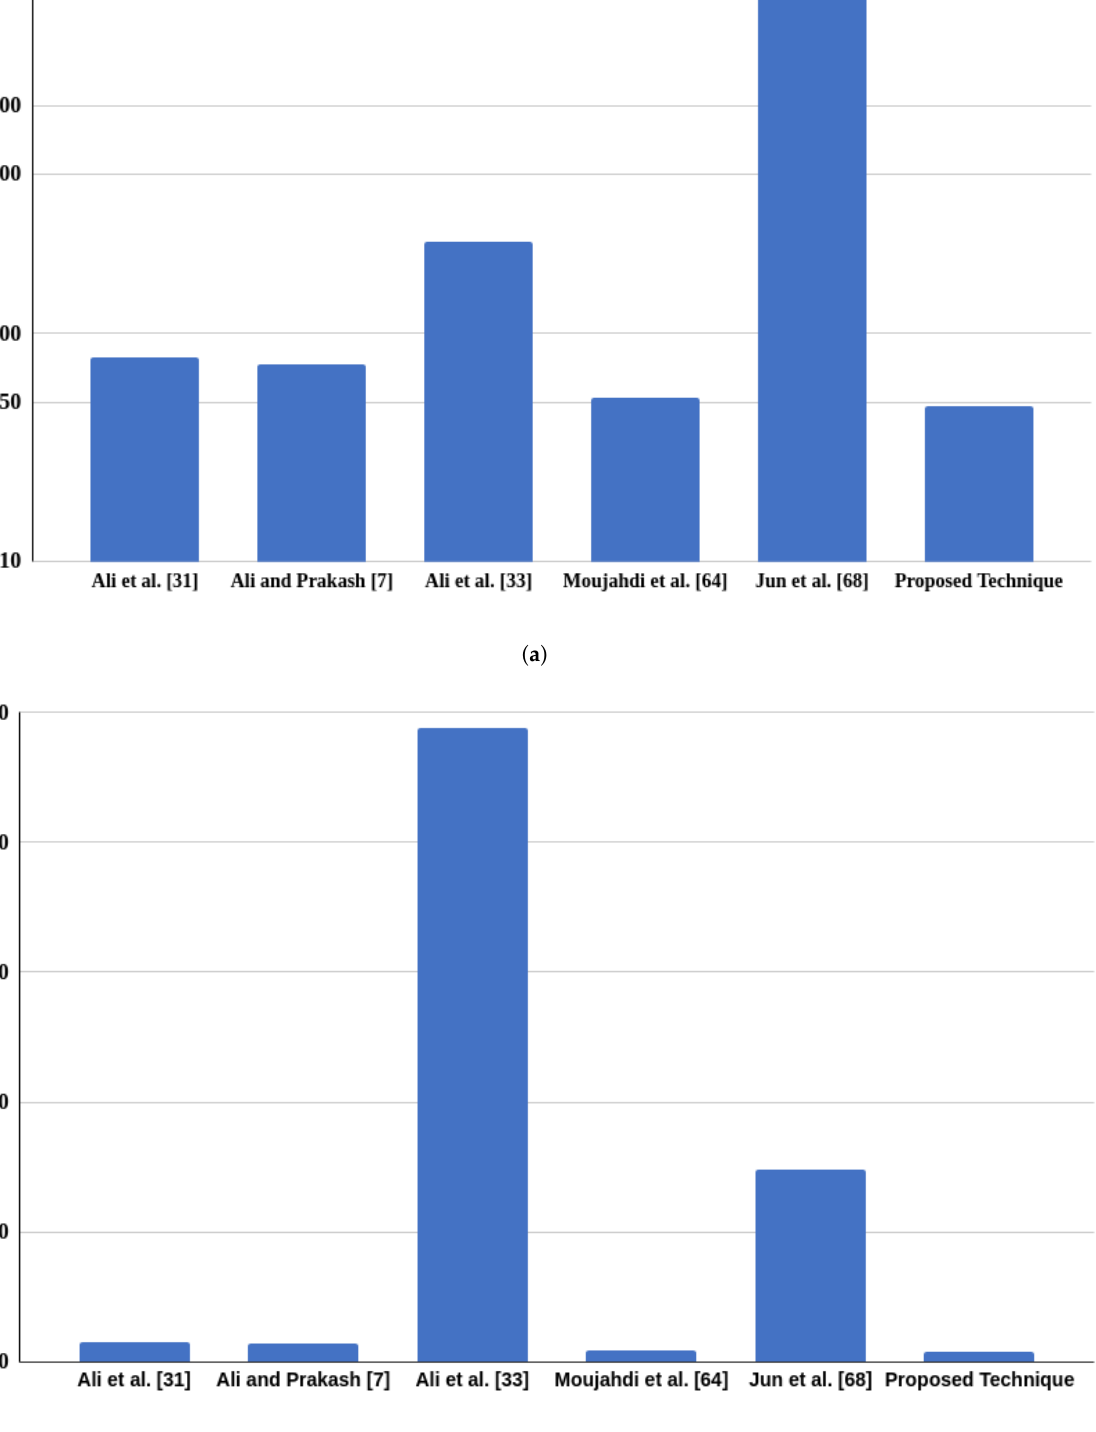
Figure 9. Average time taken (in milliseconds) by various techniques for ( a ) template generation, ( b ) template matching. It can be observed from Table 2 that FVC2002 DB1, DB2, and DB3 are the most extensively used databases, and we know that IIT Kanpur is a large database [7]. Hence, for the rest of the analysis, these databases have been chosen. The KS test values